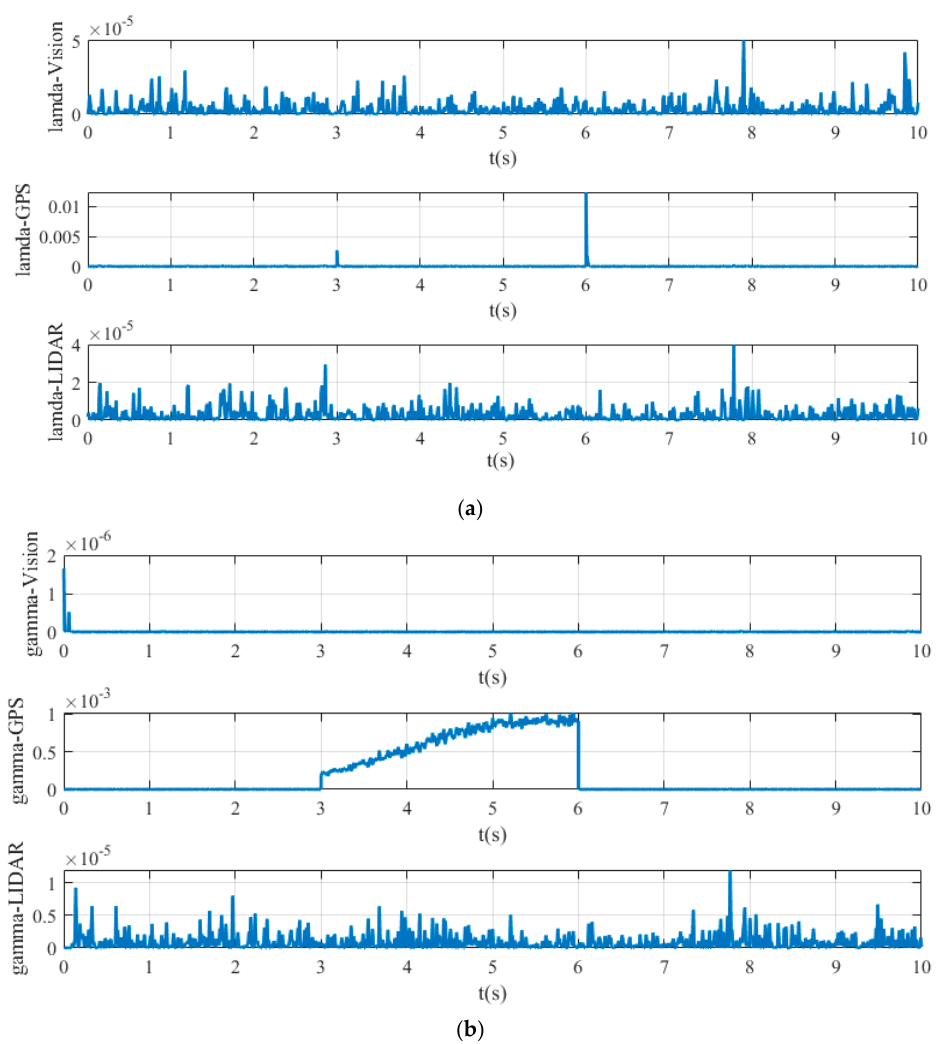
Figure 11. Lateral position test statistic of: ( a ) state Chi-square test; ( b ) residuals Chi-square test.